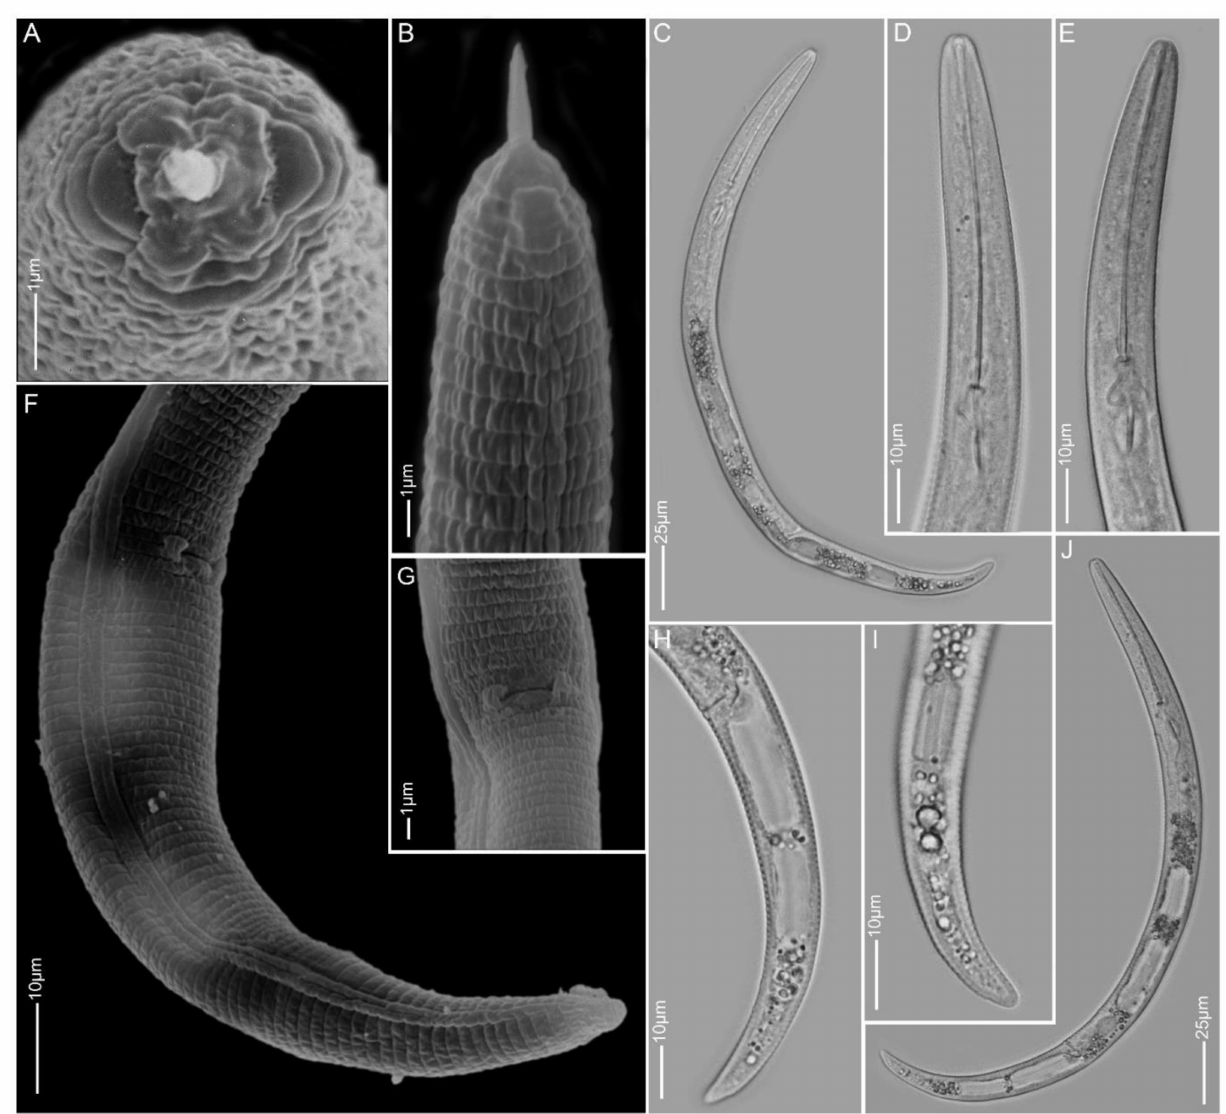
Figure 1. Light and scanning electron microscopy images of Paratylenchus aculentus females: ( A ) face view; ( B , D,E ) anterior region; ( C,J ) total body; ( G ) vulva region; ( F , H , I ) tail